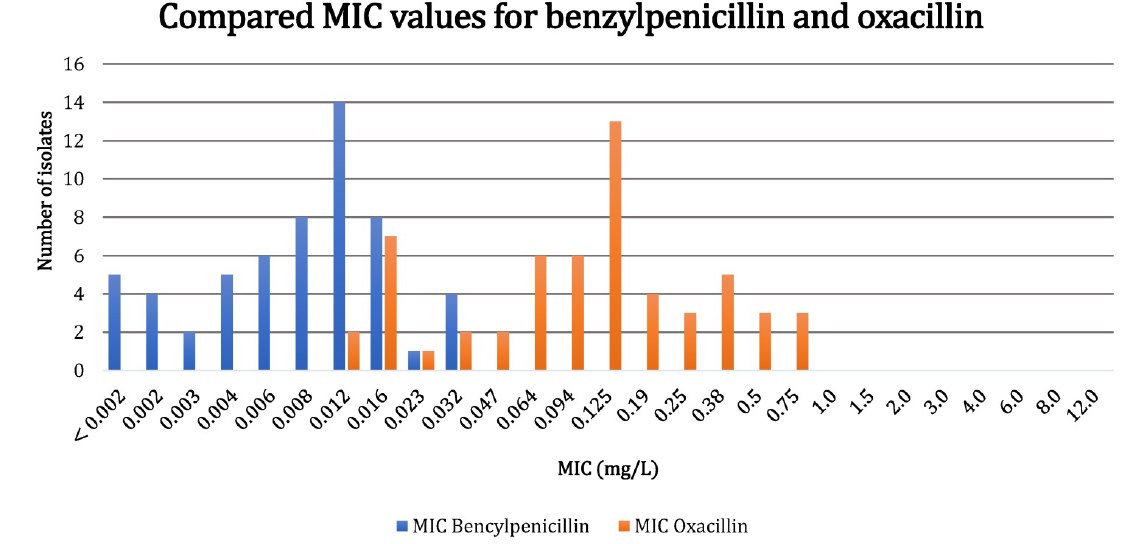
Figure 2. Comparison of MIC values determined by Etest for benzylpenicillin and oxacillin of 57 isolates of Cutibacterium acnes obtained from orthopedic implant infections. The lowest MIC values for benzylpenicillin are < 0.002 mg/L and those for oxacillin are < 0.016 mg/l. Due to the different scales on the Etest strips, the lowest value for oxacillin (< 0.016 mg/L) is marked in the figure as 0.012 mg/L. The real MIC values for these strains are assumed to be 0.012 mg/L or lower, but cannot be measured due to the scale on the Etest